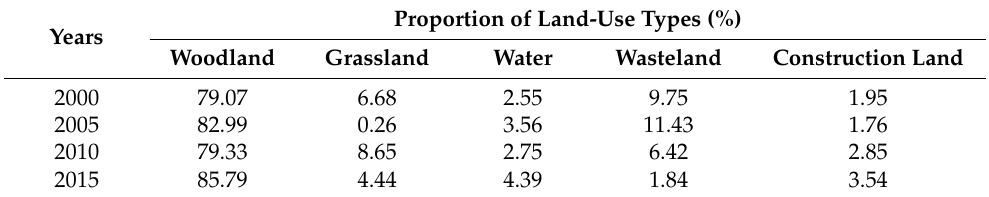
Table 1. The proportion of land-use types in 2000, 2005, 2010, and 2015.